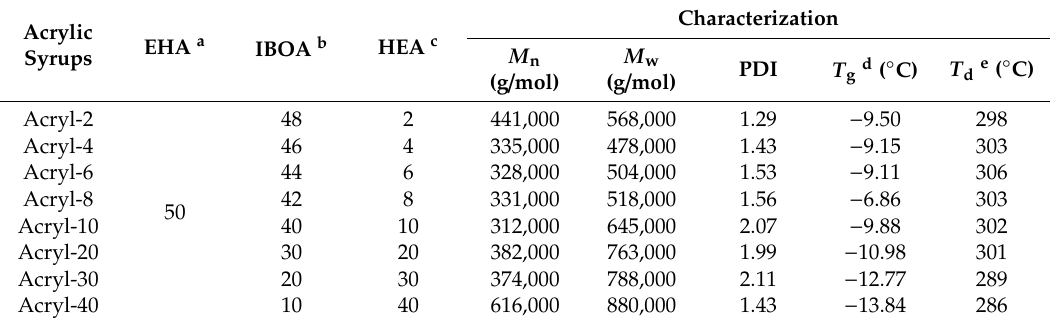
Table 1. Monomer composition and molecular weight of hydrophilic acrylic